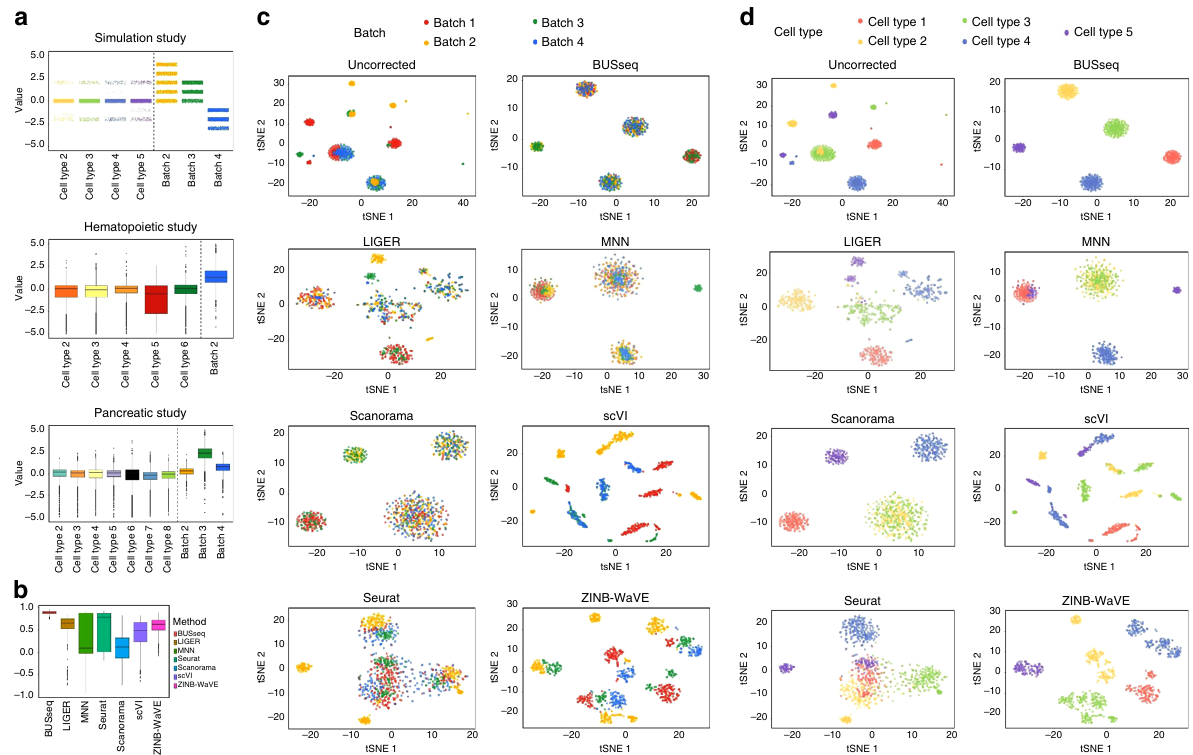
Fig. 3 Comparison of batch effects correction methods in the simulation study. a Comparison of the magnitude of cell type effects and batch effects in the simulation study and two real applications. The subpanel for the simulation study jitters around the assumed values for β and ν . The boxplots show the distributions of the estimated cell type effects b β and batch effects b ν by BUSseq in the two real studies. The magnitude of the batch effects and cell type effects in the simulation study were chosen to mimic the real data scenarios. b The boxplots of silhouette coef fi cients for all compared methods. In these boxplots, the central line denotes the median; the upper and lower bounds represent the fi rst and third quartiles; and the whiskers extend to a maximum of 1.5 times the interquartile (IQR) beyond the box, where the IQR is the difference between the third and the fi rst quartiles. c T-distributed Stochastic Neighbor Embedding (t-SNE) plots colored by batch for each compared method. d t-SNE plots colored by true cell type labels for each compared method. BUSseq successfully corrects the batch effects and perfectly clusters cells into different cell types in the simulation study, whose batch effects and cell type effects are at the same scale as those of the two real